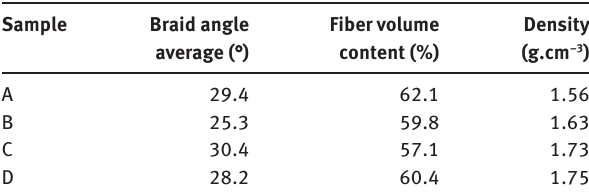
Table 1: The parameters of specimen for 3-D braided composite materials.